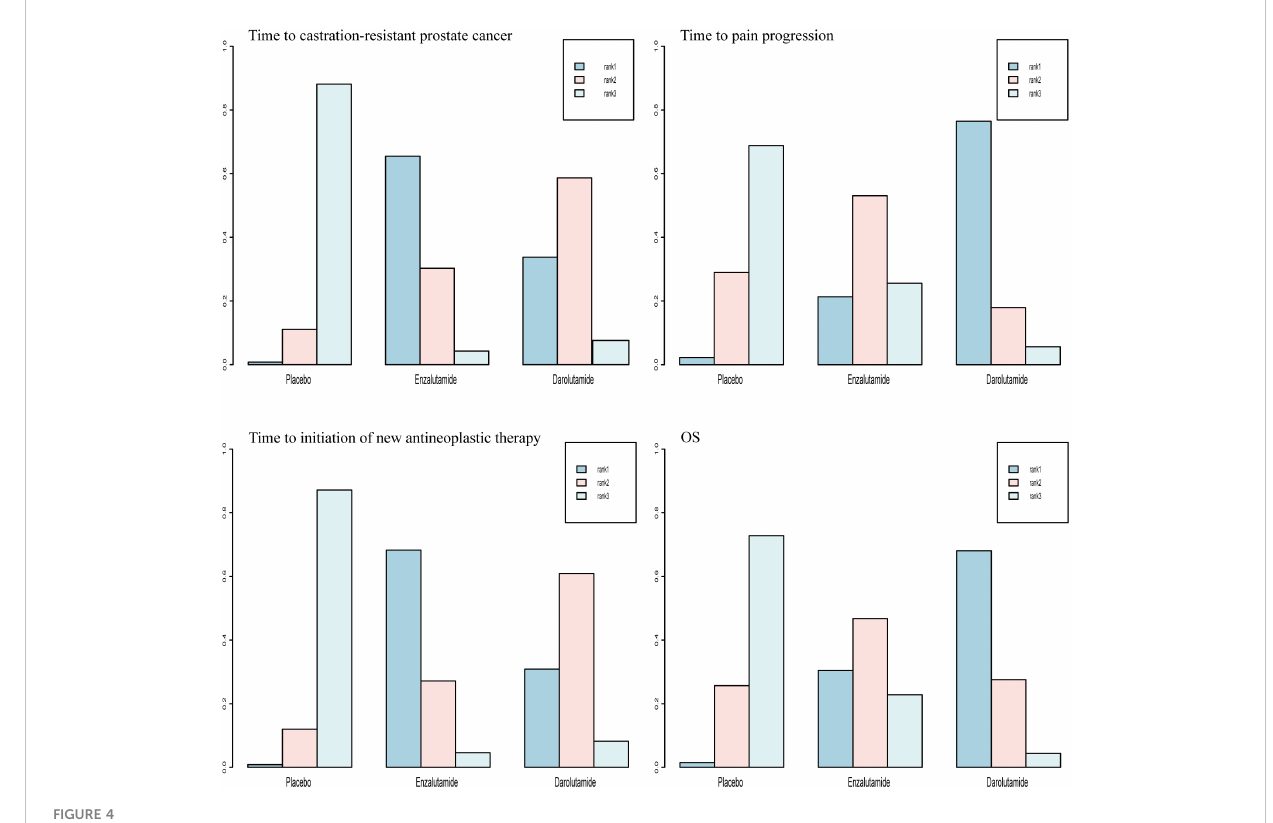
FIGURE 4 Rank probabilities of the SGARIs studied in the mHSPC study.